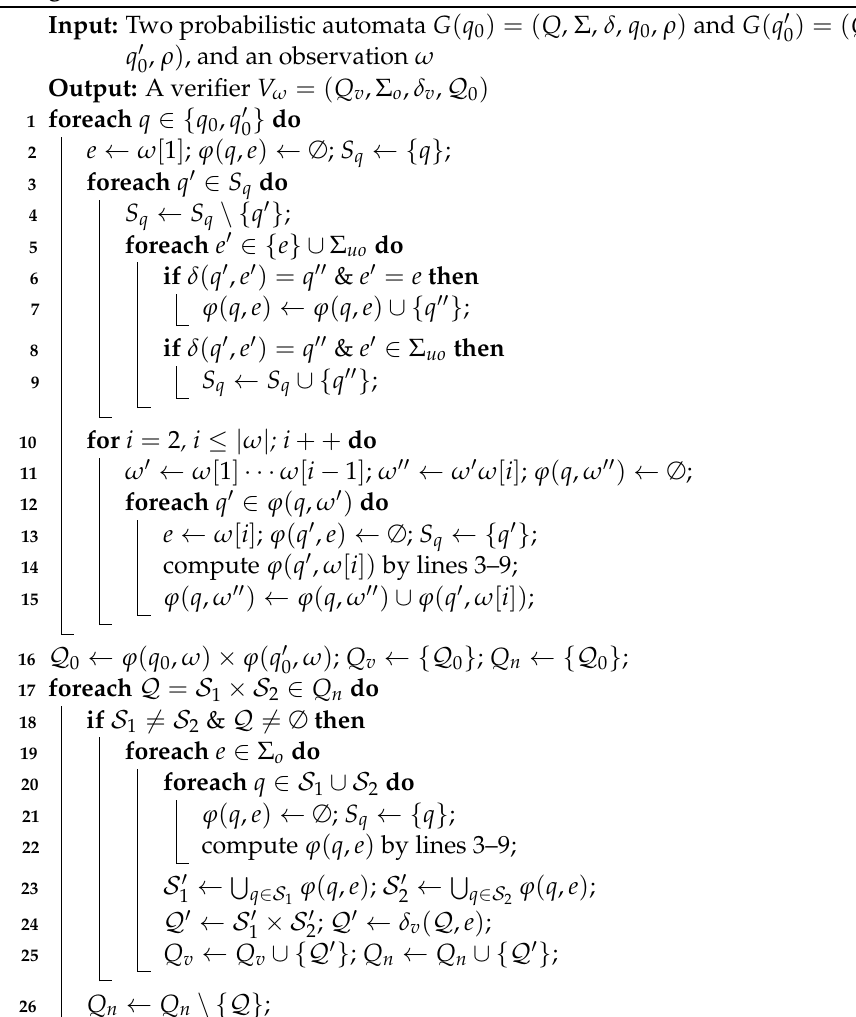
Algorithm 1: Construction of a